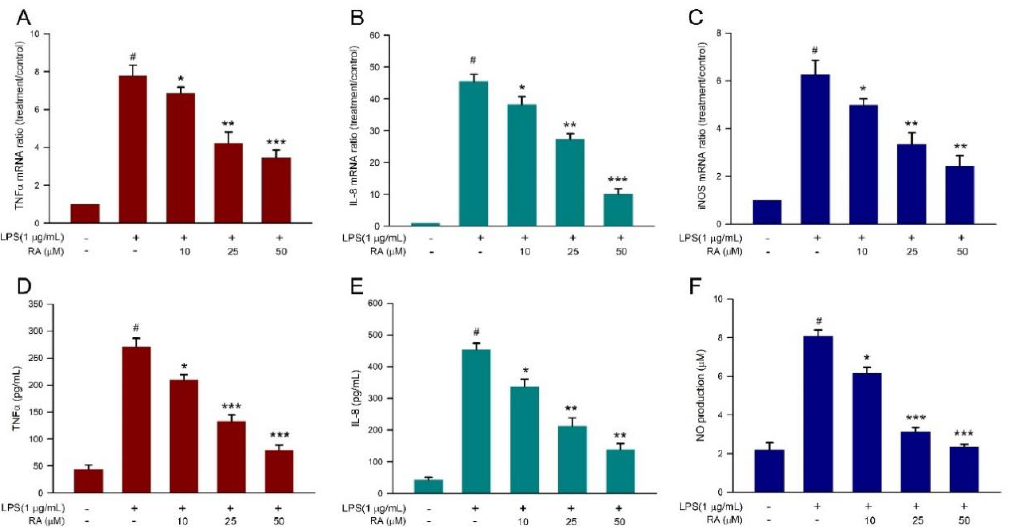
Figure 2. RA downregulated the mRNA expression and production of pro-inflammatory mediators by A7r5 cells in the presence of LPS. Cells were pretreated with RA at 10, 25, or 50 μM for 1 h, then treated with LPS for 6 h or 24 h. The 6 h LPS-treated cells were subjected to ( A – C ) mRNA analysis using qPCR, and the 24 h LPS-treated cell culture medium was collected for ( D – F ) pro-inflammatory mediator production analysis using ELISA or Greiss reaction. The change in mRNA expression was presented as the ratio of treatment/control. #, p < 0.01 as compared to the control. *, **, and ***, p < 0.05, p < 0.01, and p < 0.005 as compared to LPS alone.